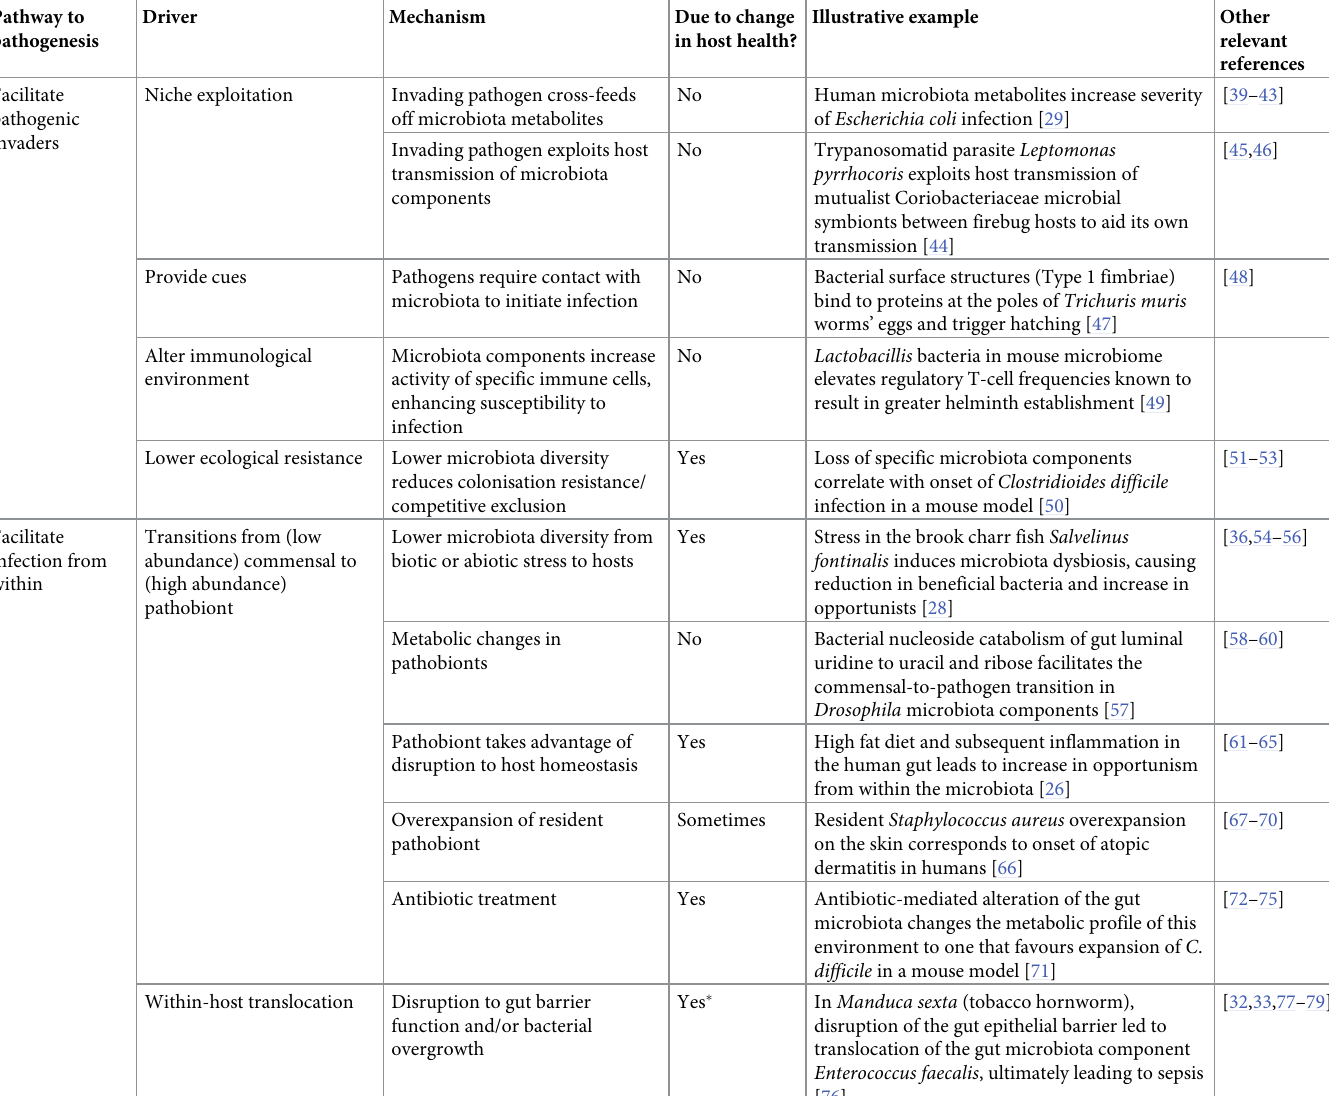
Table 1. Summary of the drivers and mechanisms by which the microbiota facilitate harmful infection. Pathway to